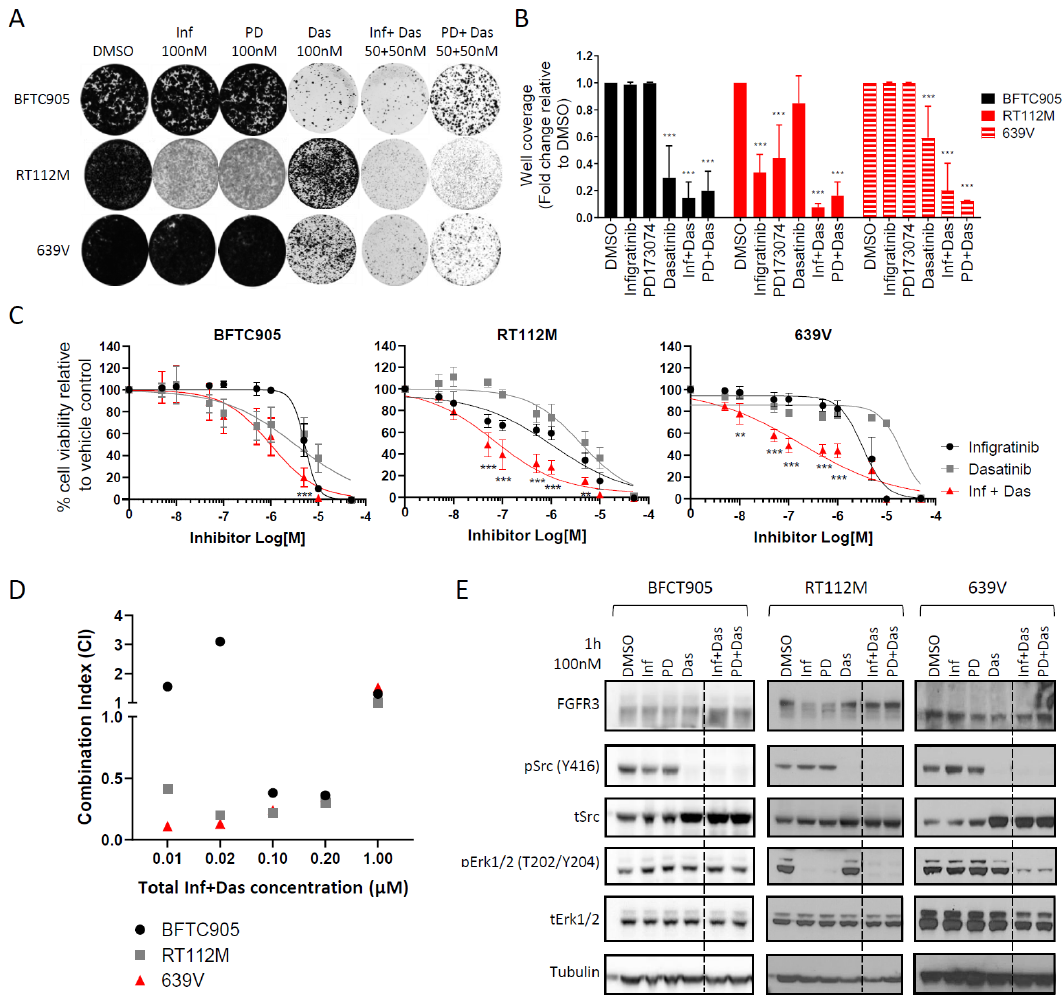
Figure 4. Targeting the Src pathway enhances the efficacy of selective FGFR inhibitors in urothelial cancer cell lines with FGFR3 molecular alterations. ( A ) Representative images of long term colony formation assay in urothelial cancer cell line panel upon treatment with infigratinib, PD173074, dasatinib as single agent or in combination as well as DMSO control at the indicated doses for 2 weeks. ( B ) Bar plots showing the quantification of well coverage of the colony formation assay in panel A. Data for each cell line are normalised to DMSO control treatment (n = 3). Statistical analysis of drug treatment versus DMSO was performed by two-way ANOVA with Dunnett’s post-hoc multiple comparison adjusted p -value (*** p < 0.001). ( C ) Dose-response curves of the urothelial cancer cell lines upon treatment with infigratinib and dasatinib either as single agents or in combination for 72 h. For the combination arm, cells were treated with infigratinib and dasatinib in a 1:1 ratio with each drug at half the dose of the single agent. Cell viability is normalised to DMSO control treatment ( n = 3). Statistical analysis of the combination arm versus either single agent at each dose was evaluated using two-way ANOVA with Dunnett’s post-hoc multiple comparison adjusted p -value at each drug dose (** p < 0.01, *** p < 0.001). ( D ) Combination index (CI) measurements for infigratinib and dasatinib in urothelial cancer cell lines based on dose response data in panel C. Synergy (CI < 1) in RT112M and 639V is shown across all doses tested up to 1 µM. ( E ) Immunoblot of Erk1/2 and Src phosphorylation levels in urothelial cancer cells treated with single agent selective FGFR inhibitor or dasatinib and in combination for 1 h. The combination arm was administered in a 1:1 ratio, with the indicated concentration representing the total drug concentration used. Data presented for ( B ) and ( C ) represent mean ± SD. Inf – infigratinib, PD – PD173074, Das – dasatinib.